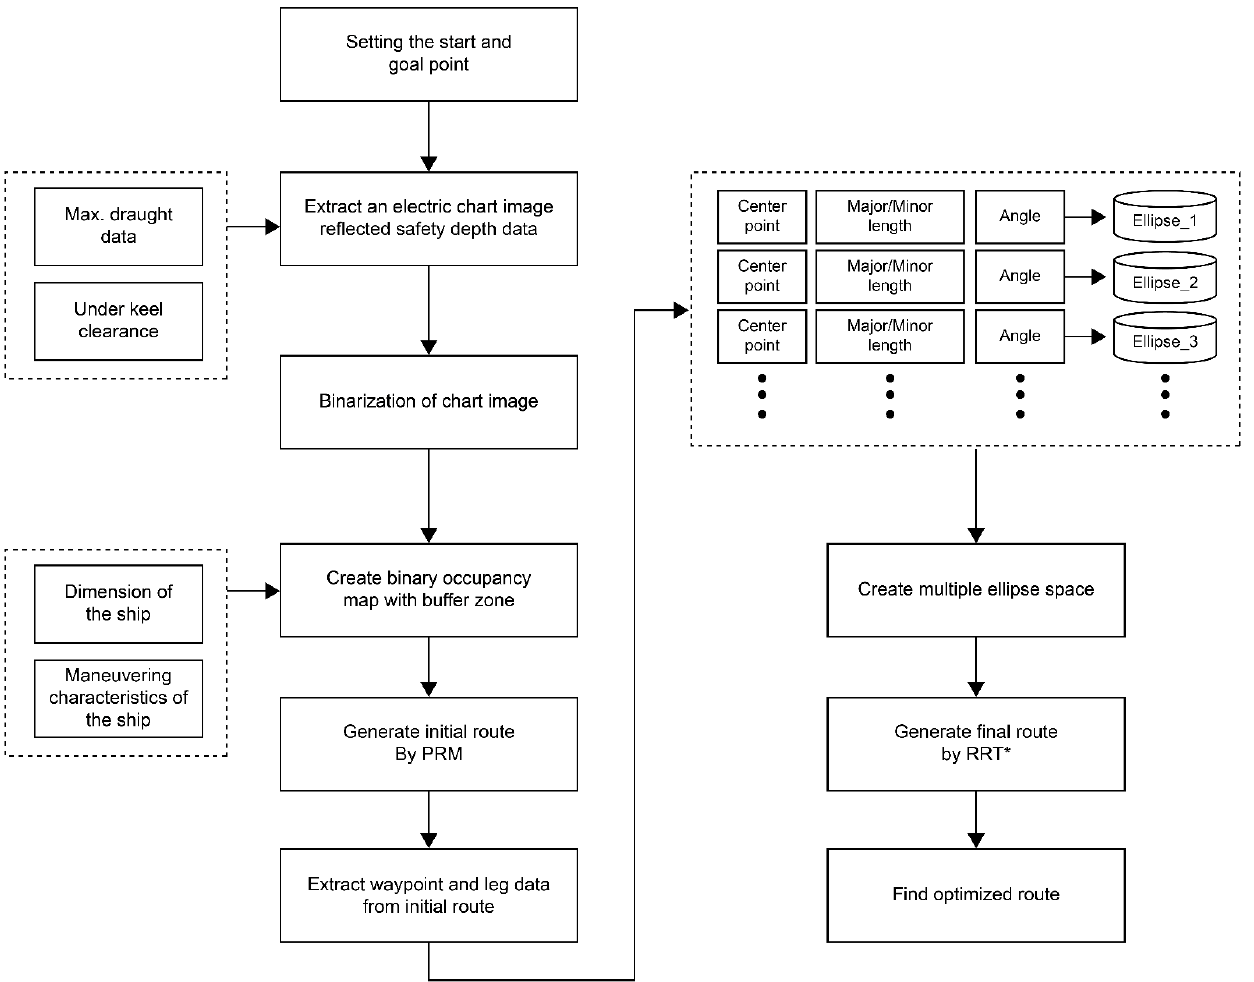
Figure 6. Process flow of the proposed route ‐ planning algorithm.